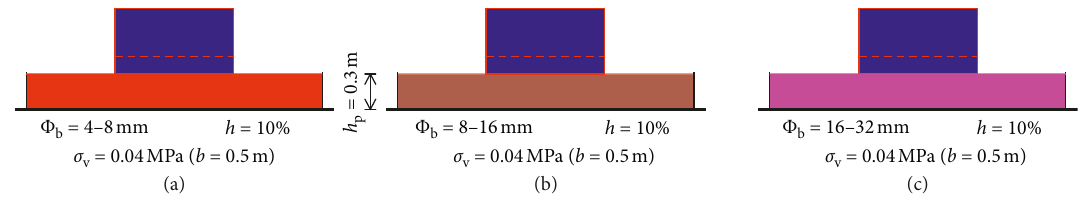
Figure 4: Analysed pebble layer compaction. (a) MS � 10MPa. (b) MS � 30MPa. (c) MS � 60 MPa.